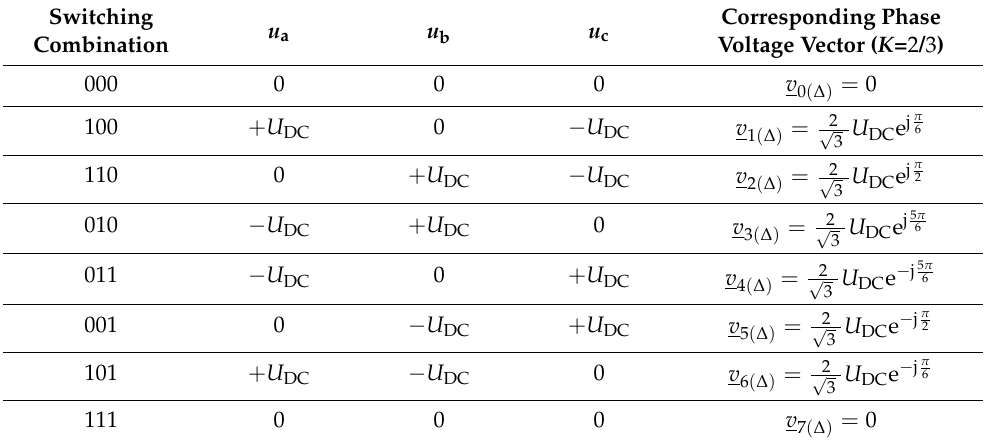
Table 1. Switching combinations and corresponding voltage vectors for delta-connected machine.